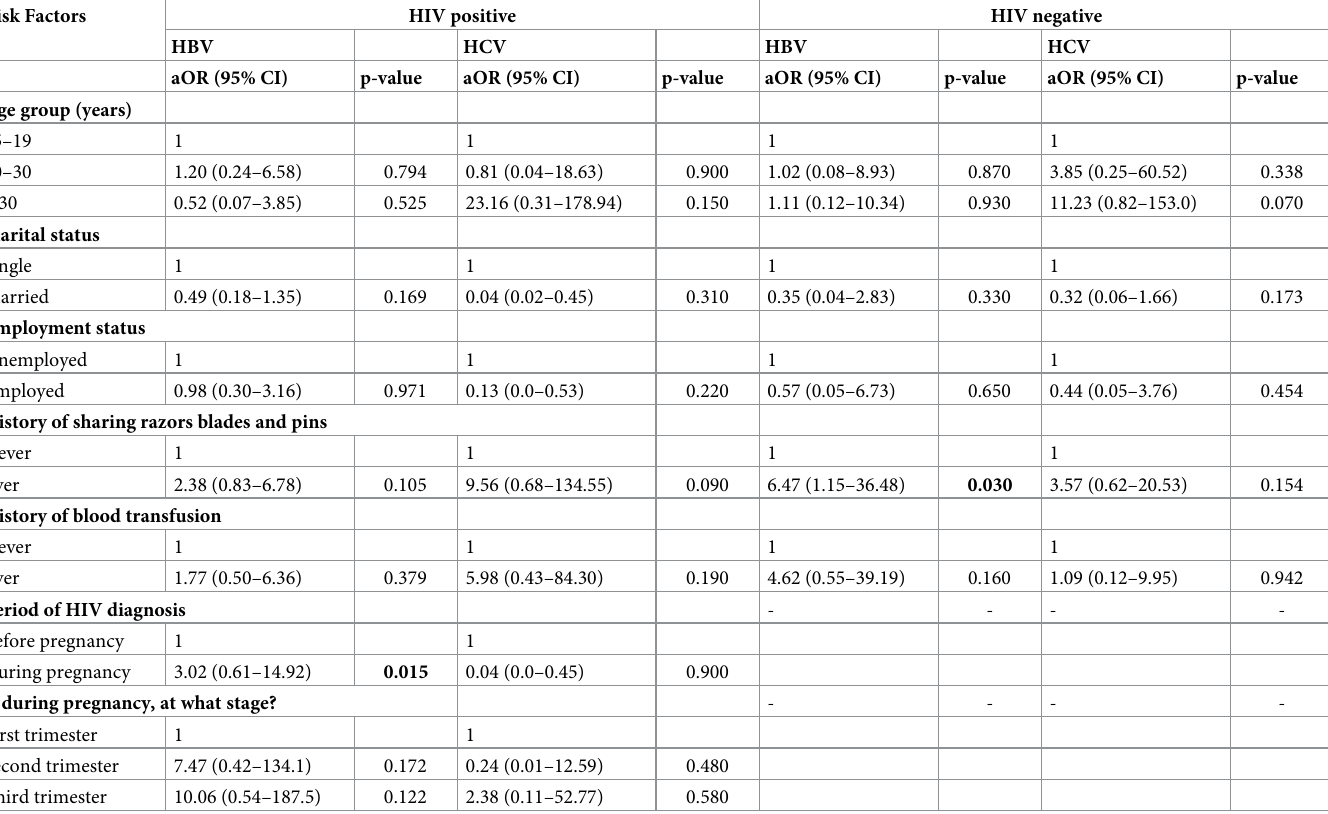
Table 4. Multivariate logistic regression analysis of risk factors for HBV and HCV co-infections in HIV positive and HIV negative pregnant